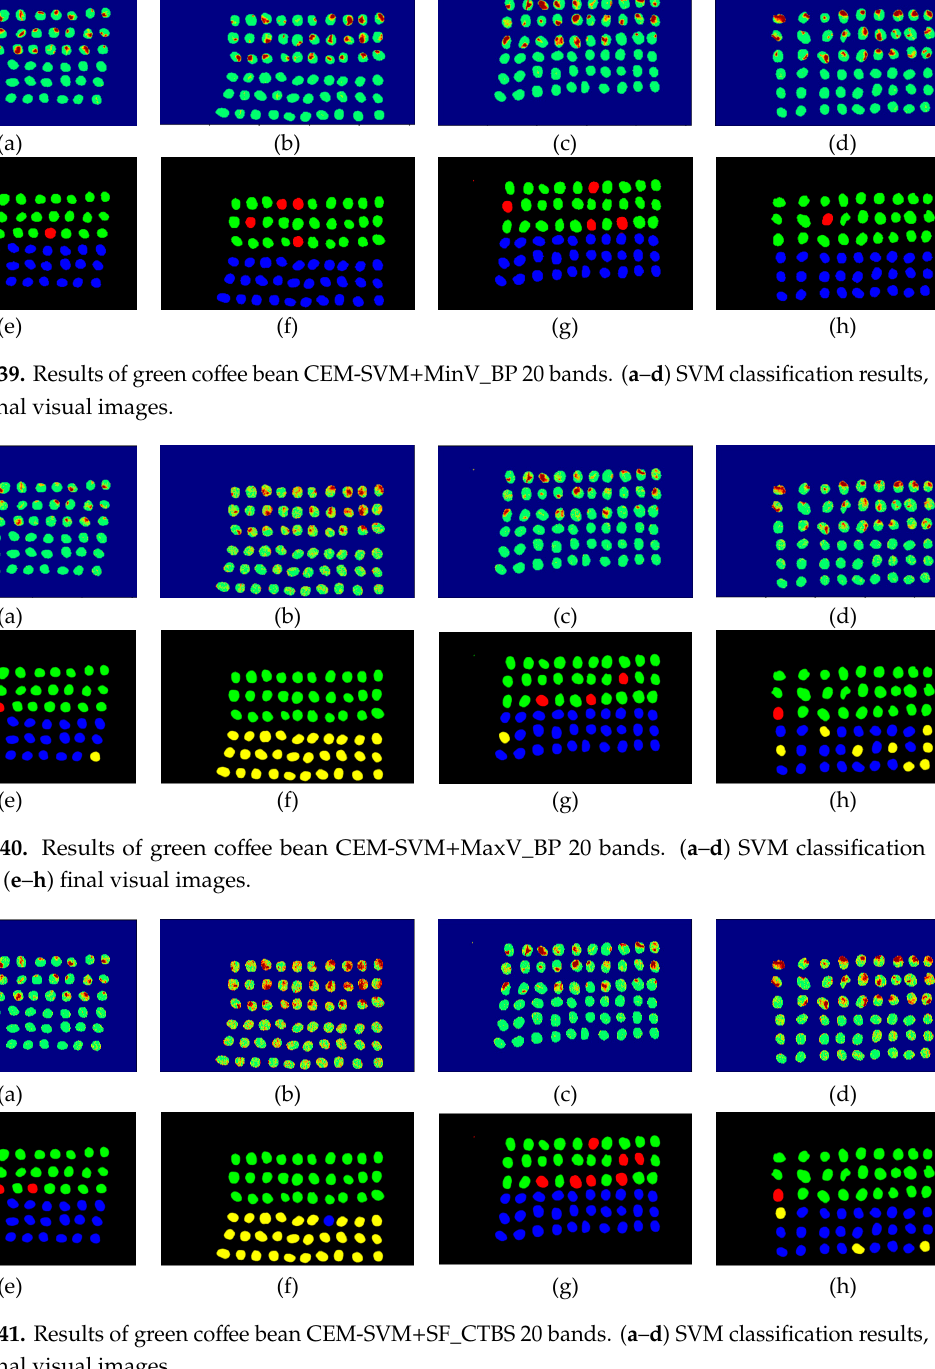
Figure 38. Results of green coffee beans CEM-SVM+CEM_BDM 20 bands. (a-d) SVM classification results, (e-h) final visual images.